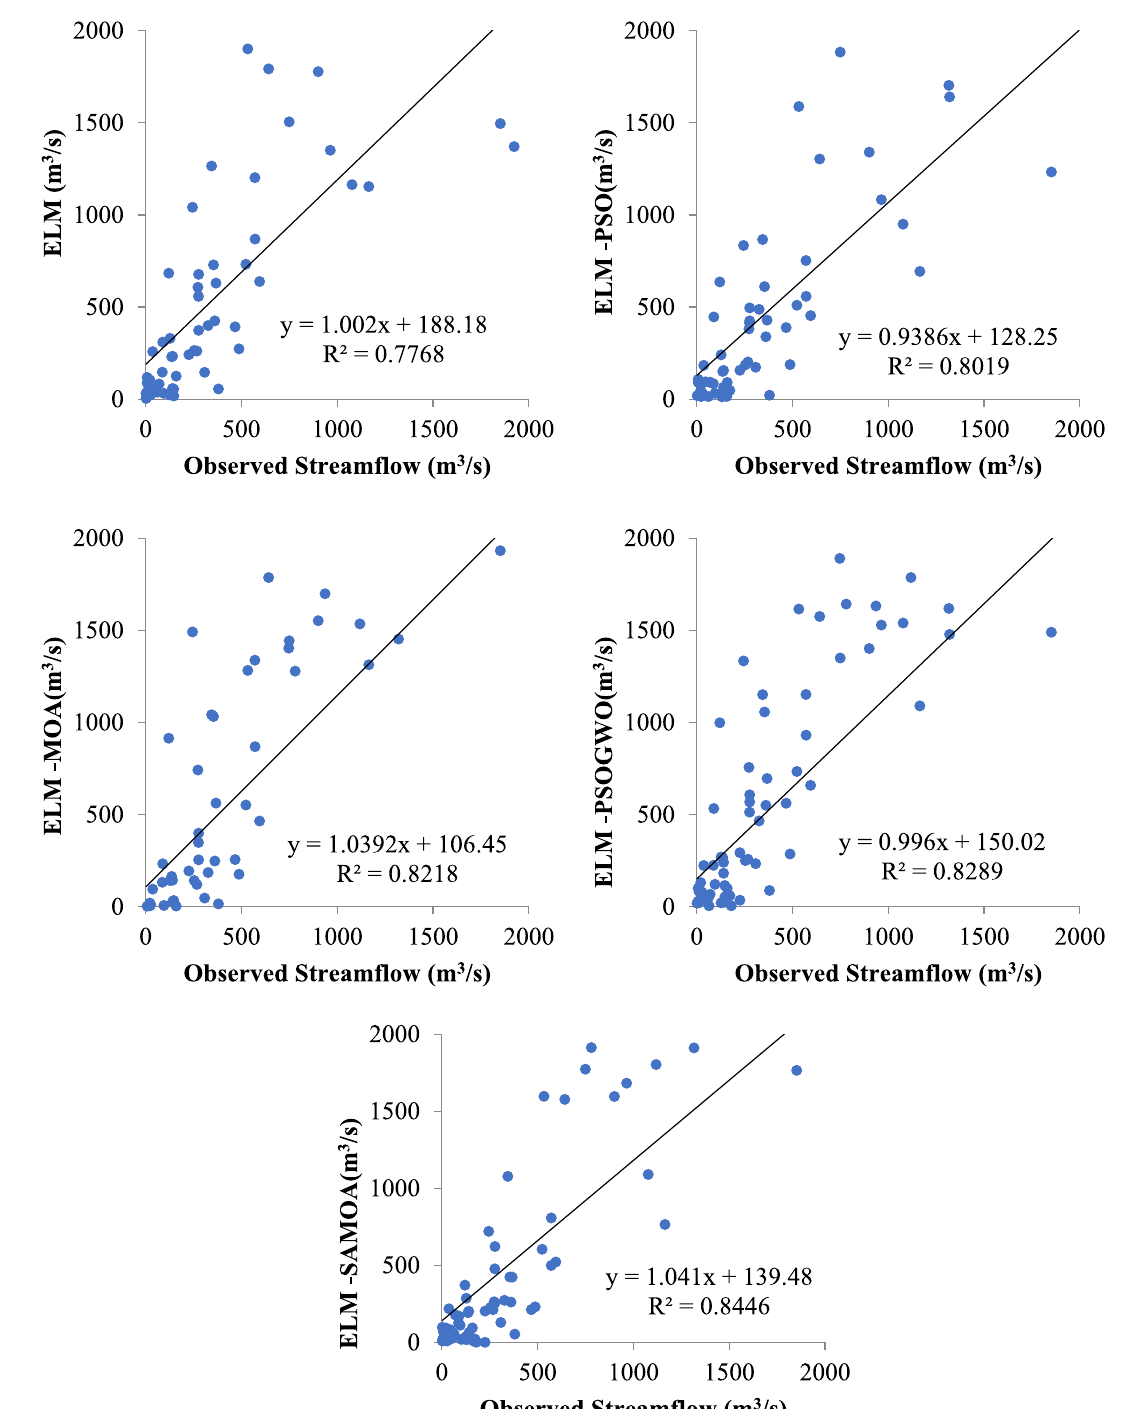
Fig. 12 Scatterplots of the observed and predicted streamflows by different ANFIS-based models in the test period of Gorai Station (d/s) using Padma station (u/s)